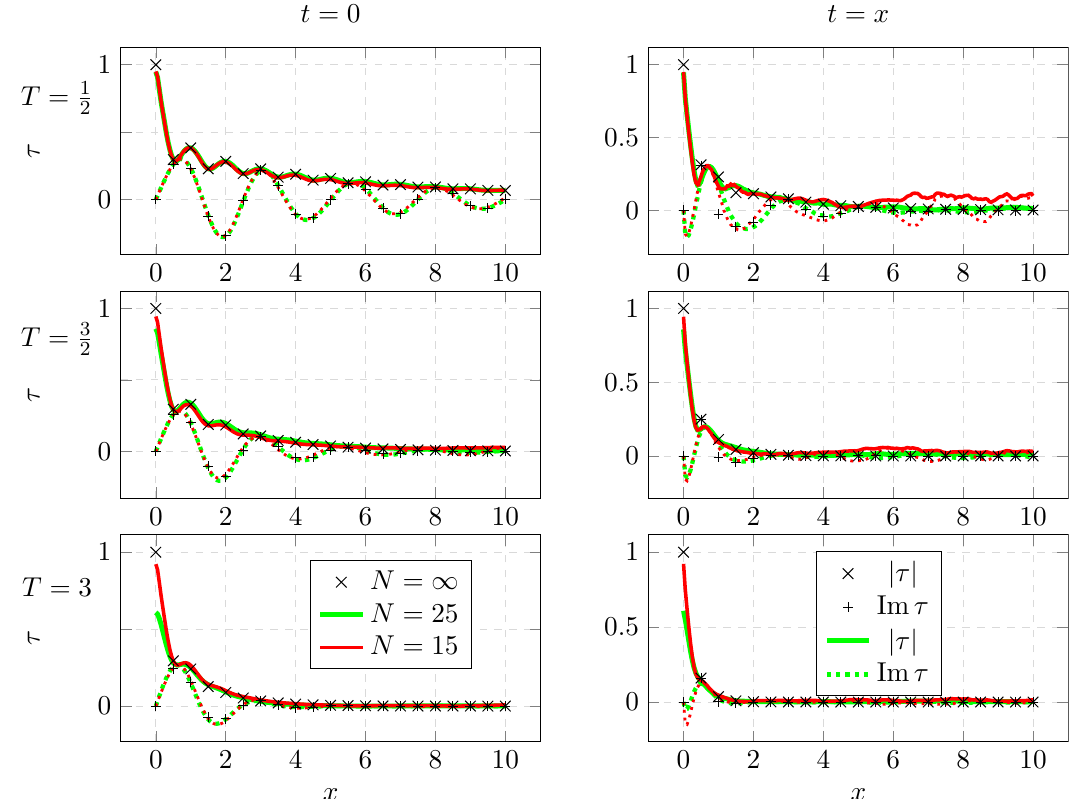
Figure 19: Numerical calculation of τ via the algorithm, plotted against position x . Green lines have L = 25 and chemical potential µ such that the expected filling N = L in the grand-canonical ensemble, red the same with L = 15. For comparison, these are plotted alongside the exact result of the Fredholm in black marks. The solid lines (X’s) are the envelope | τ | , while the corresponding dotted lines ( + ’s) are the imagi- nary part, showing oscillations. From top to bottom, temperature increases through T ∈ { 0.5,1.5,3 } . The left column is the static τ -function, right the ray x / t = 1. We see near-perfect agreement away from x = 0, where the unsaturated sum rule prevents us correctly interfering all the phasors. It is also clear that L = 15 already approaches the TDL. The box size used is β = 4, shift ν = 0.4. Each numerical plot is a flat average over 50 sampled states. We expect adding samples would improve the erratic average at larger x